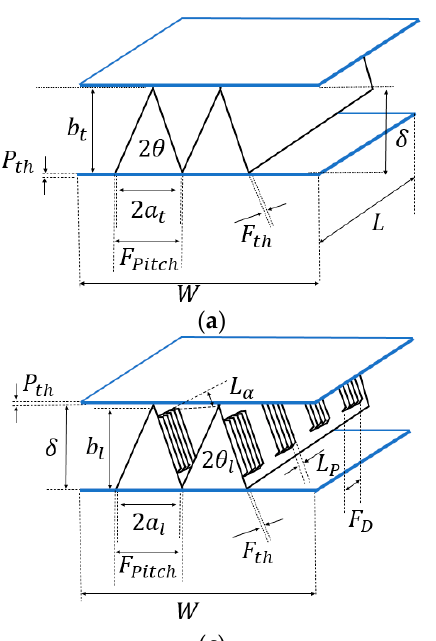
where A c (m 2 ) is the free flow area and P w ( m ) is the wetted perimeter. In plate and fin heat exchangers, the total heat transfer area per unit volume is greater compared with other technologies; this feature is referred to as area density, β (m 2 /m 3 ). The ratio of the total surface area to the volume of that side of the exchanger ( β ) is calculated as: